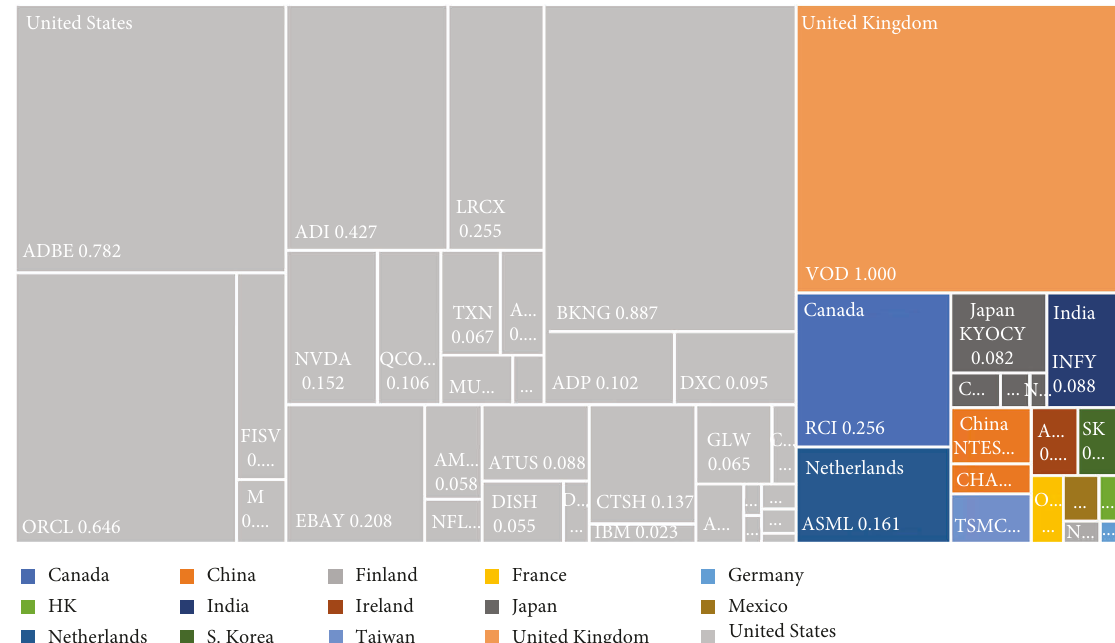
Figure 4: Tree map of marketability efficiency.